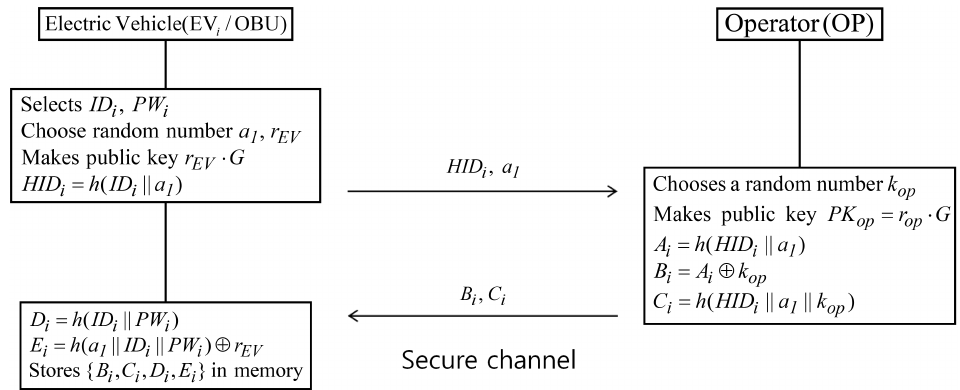
Figure 6. Registration phase of proposed scheme